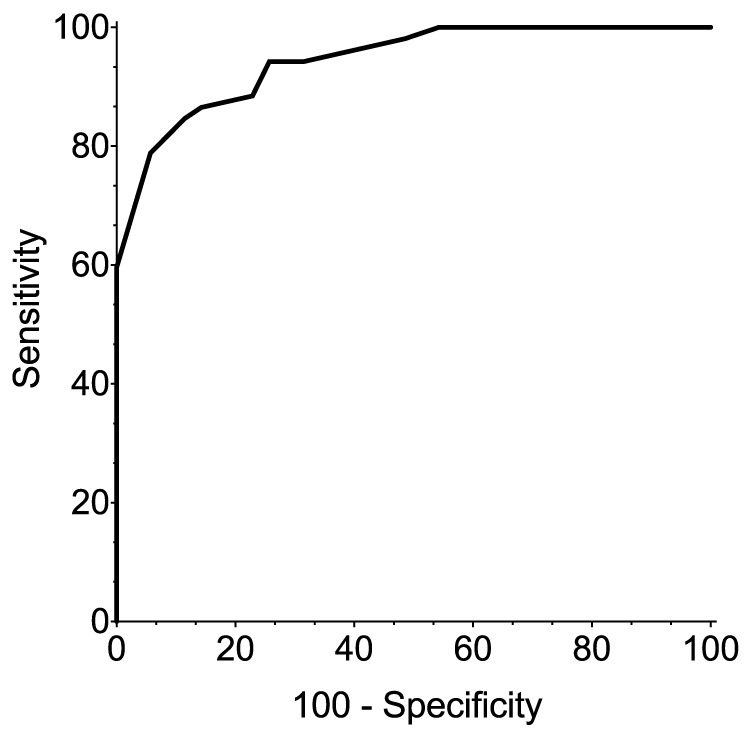
Receiver operating characteristics (ROC) curve.The optimal analgesic intervention score was >0.67, derived from a balance between the greatest values of sensitivity (84.6% [71.9–93.1]) and specificity (88.6% [73.3–96.8]. There was a significant difference in the area (0.94 [0.87–0.98], p<0.0001) under the calculated ROC curve compared with an AUC of 0.5 (representative of a non-discriminative test). n = 87 images